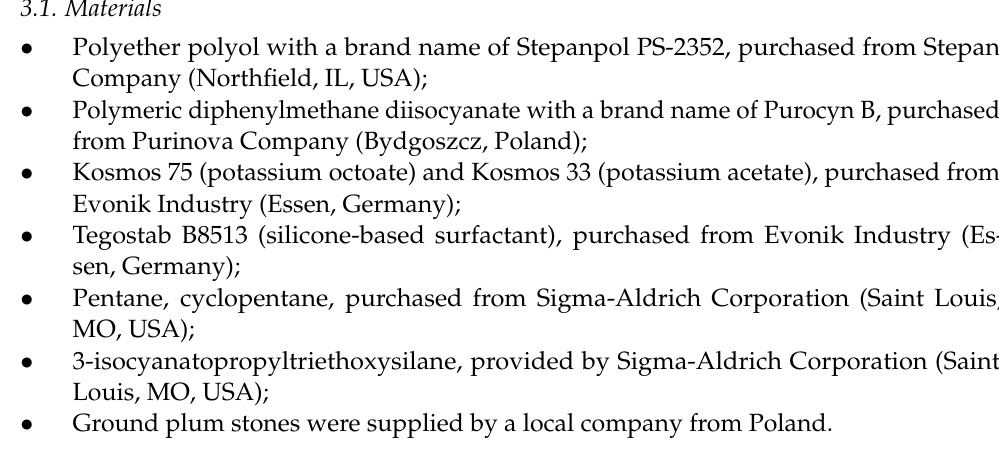
Figure 12. Images of the contact angle measured for ( a ) PUR_REF, ( b – d ) PUR_P, and ( e – g ) PUR_Si-P.